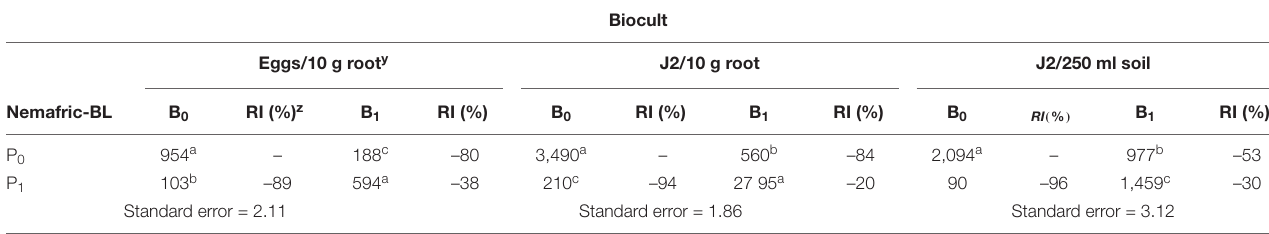
TABLE 2 | Relative impact (RI) of Biocult (B) and Nemafric-BL phytonematicide (P) on eggs in roots, second-stage juveniles (J2) in root, J2 in soil on cowpea var. Eureka at 60 days after the treatments under field conditions ( n =